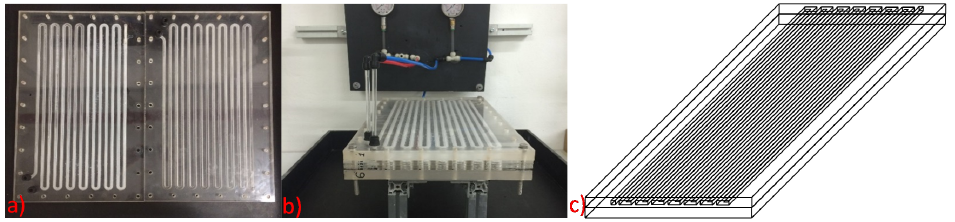
Figure 2. CrIEM reactor, ( a ) disassembled; ( b ) assembled; ( c ) 3D scheme.